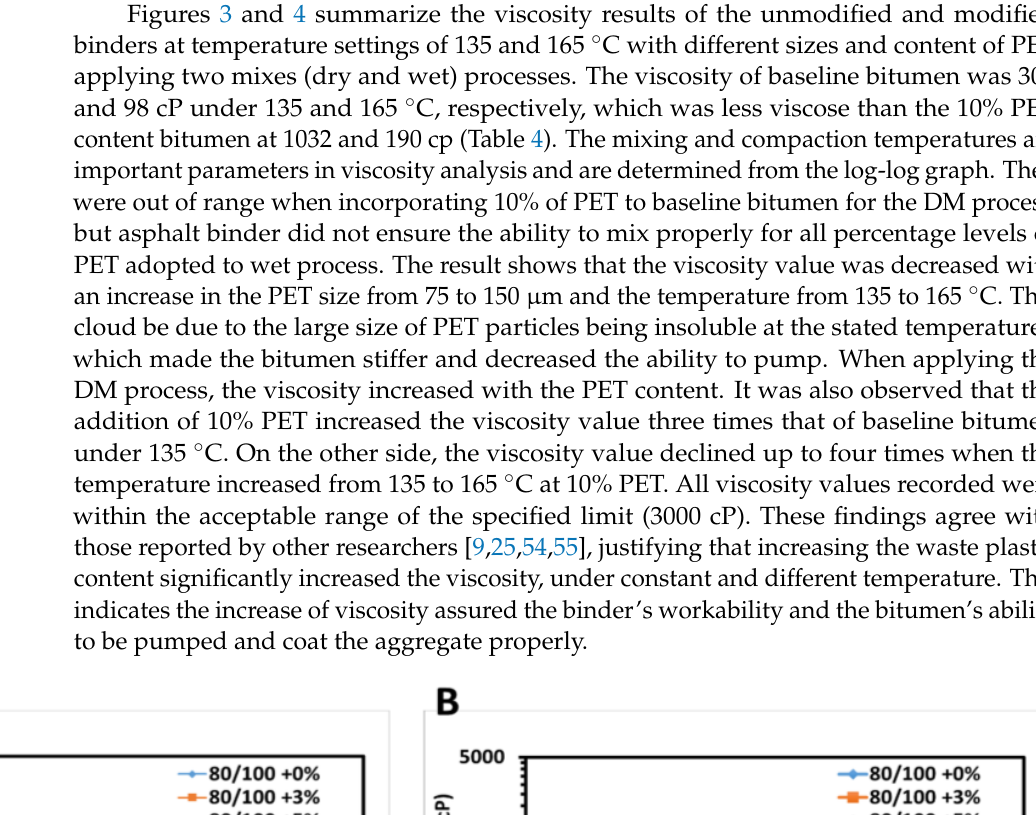
Figure 4. Viscosity-temperature curve for 150 µm PET: ( A ) dry mix mechanism, ( B ) wet mix mech- anism.